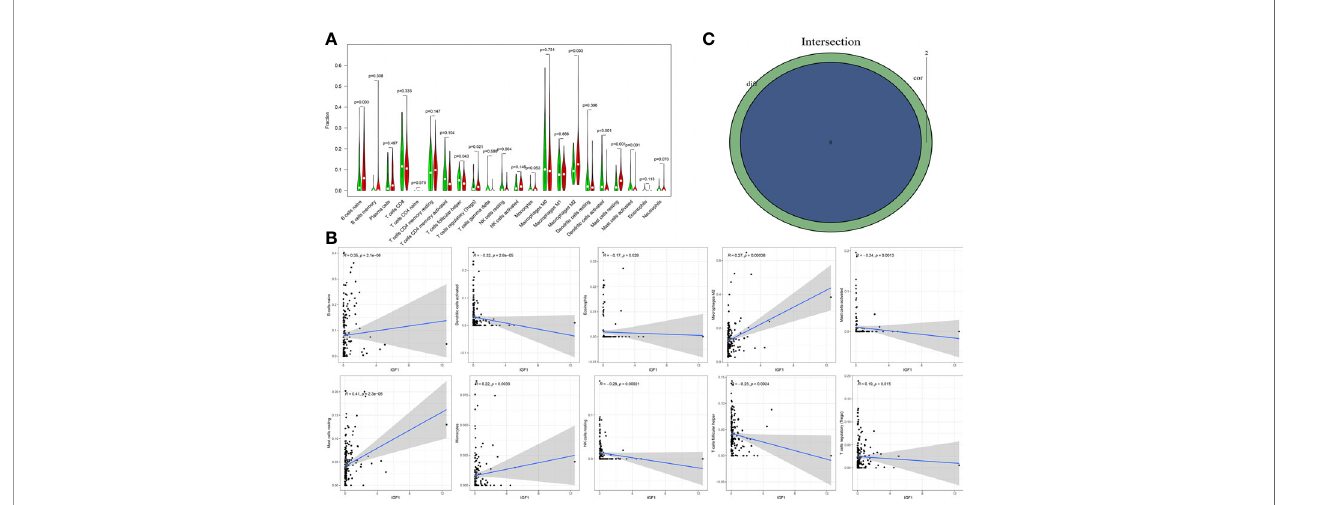
FIGURE 12 | Signi fi cant correlation between the expression of IGF1 and the fractions of tumor-in fi ltrating immune cells. (A) Violin plot showing the comparison between 22 types of tumor-in fi ltrating immune cells with IGF1 expression. (B) The correlation tests showing the correlation between 10 types of tumor-in fi ltrating immune cell proportion with the IGF1 expression (all p < 0.05). (C) Venn plot showing the collective TICs between the difference and correlation tests.